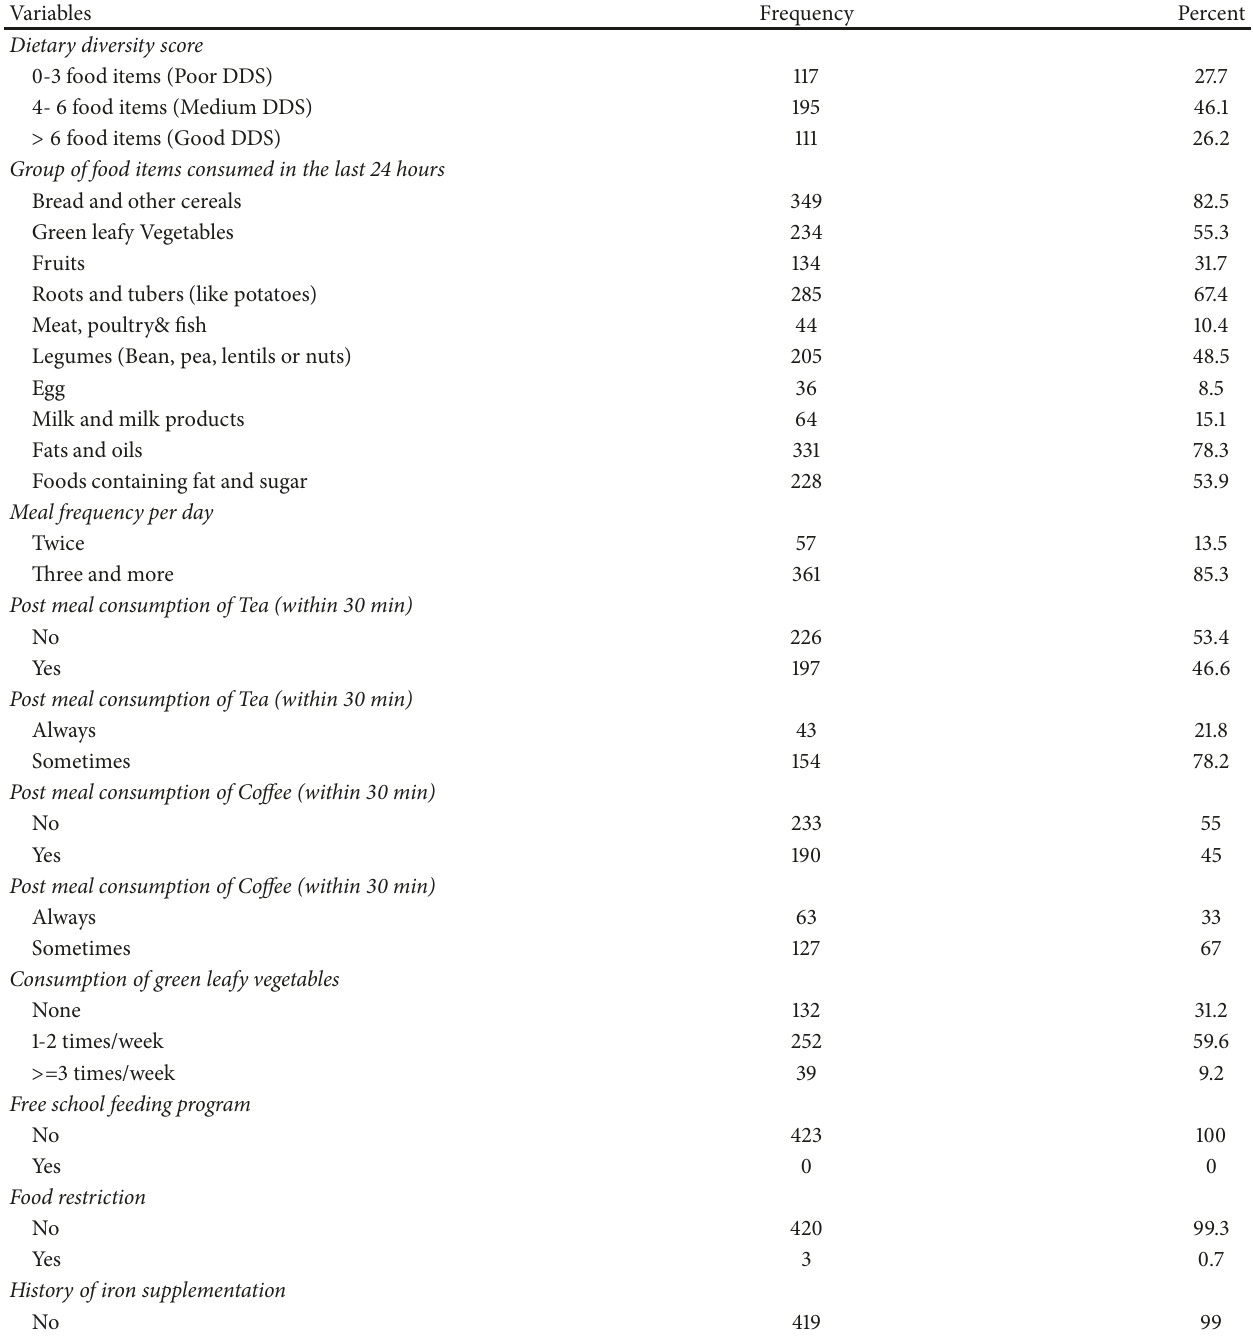
Table 3: Dietary diversity score (DDS) and practice of school adolescent girls at rural towns of Bahir Dar city Administration. 2017 (n=423). Variables Frequency